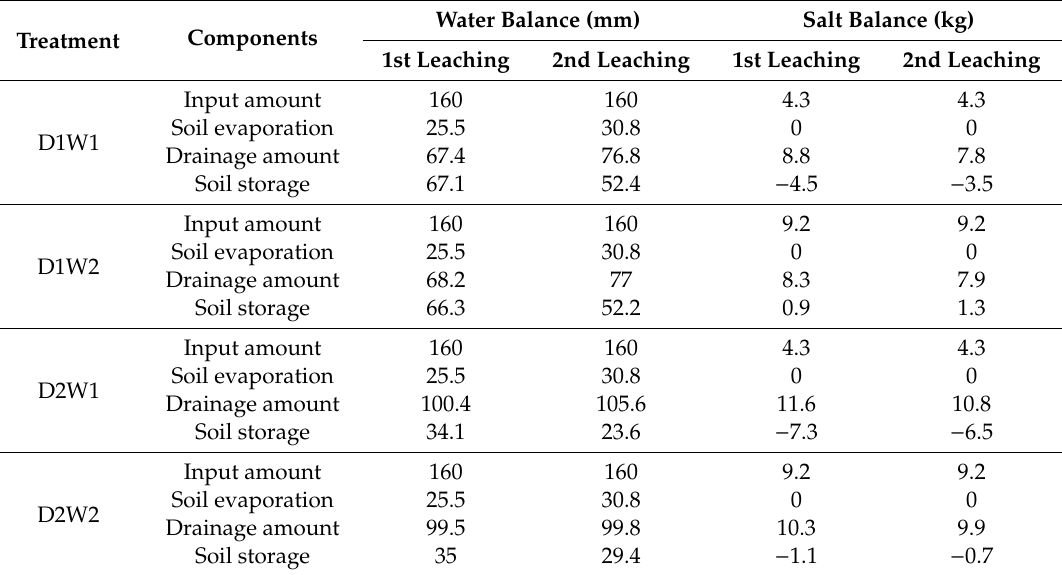
Table 4. Soil water and salt balance components in di ff erent